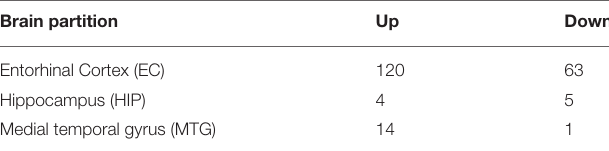
TABLE 2 | DEGs of Alzheimer’s disease in different brain